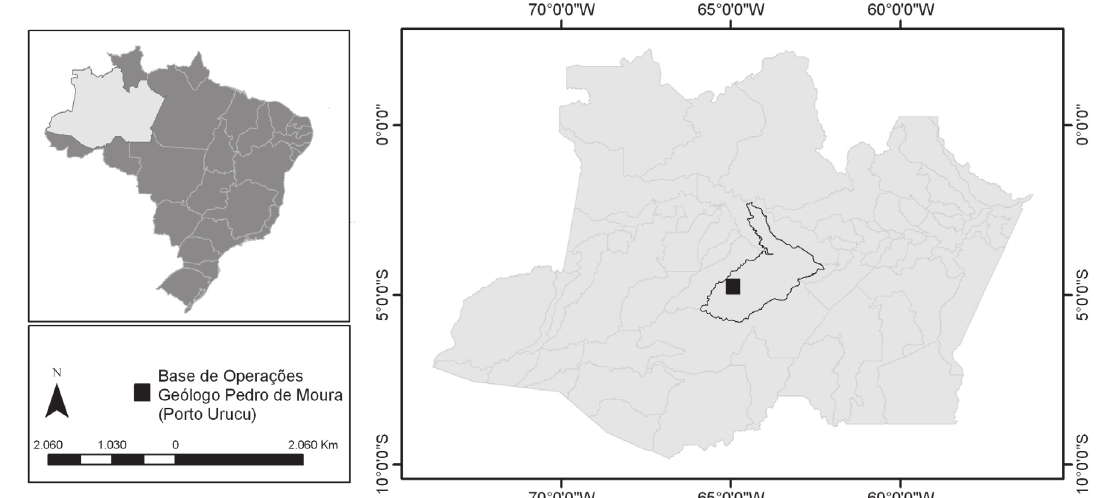
Figure 1. Urucu River Basin, Coari, Amazonas,